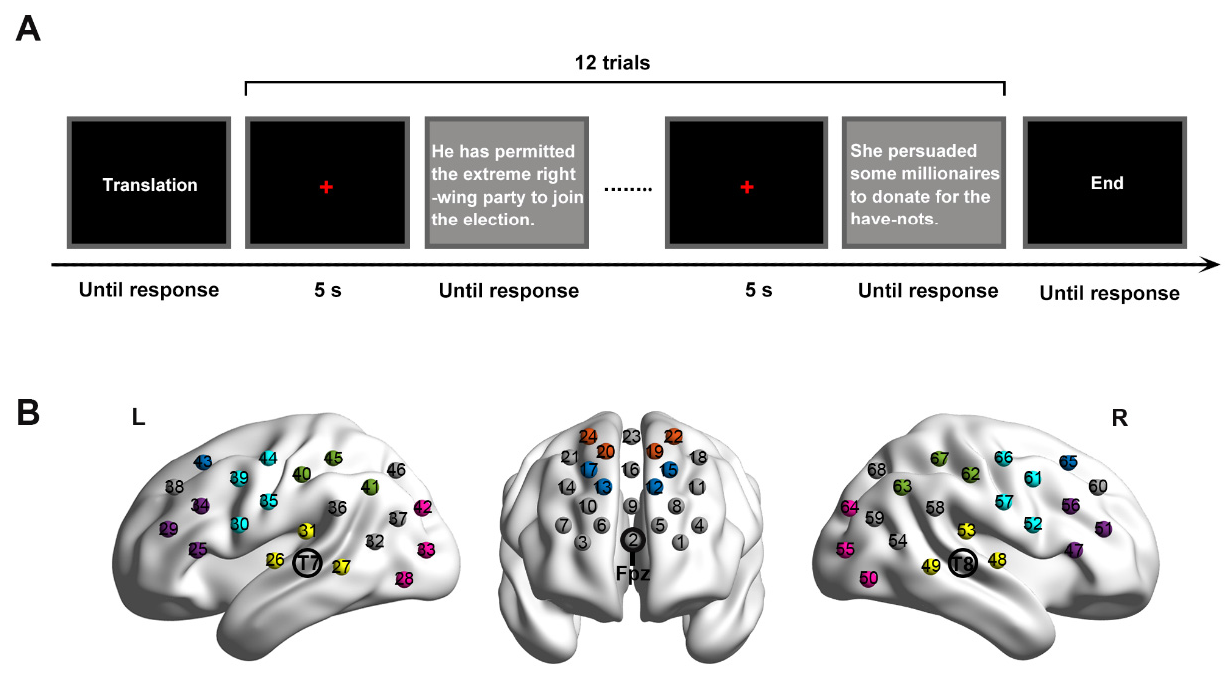
Figure 1. ( A ) One block of experimental procedure. ( B ) fNIRS channel configuration. Shaded different colors show the different brain areas (dark blue: dorsolateral prefrontal cortex. Orange: frontal eye fields. Blue–green: motor cortex. Purple: Broca’s area. Glass green: Wernicke’s area. Yellow: temporal cortex. Pink: visual cortex. L: left. R: